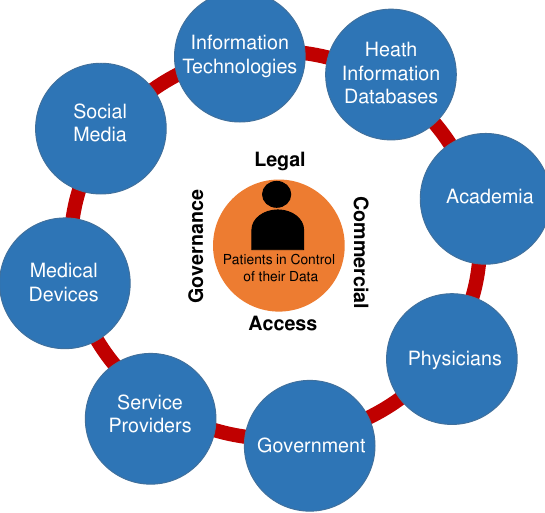
Figure 2. Patient-centric big data-enabled healthcare ecosystem.